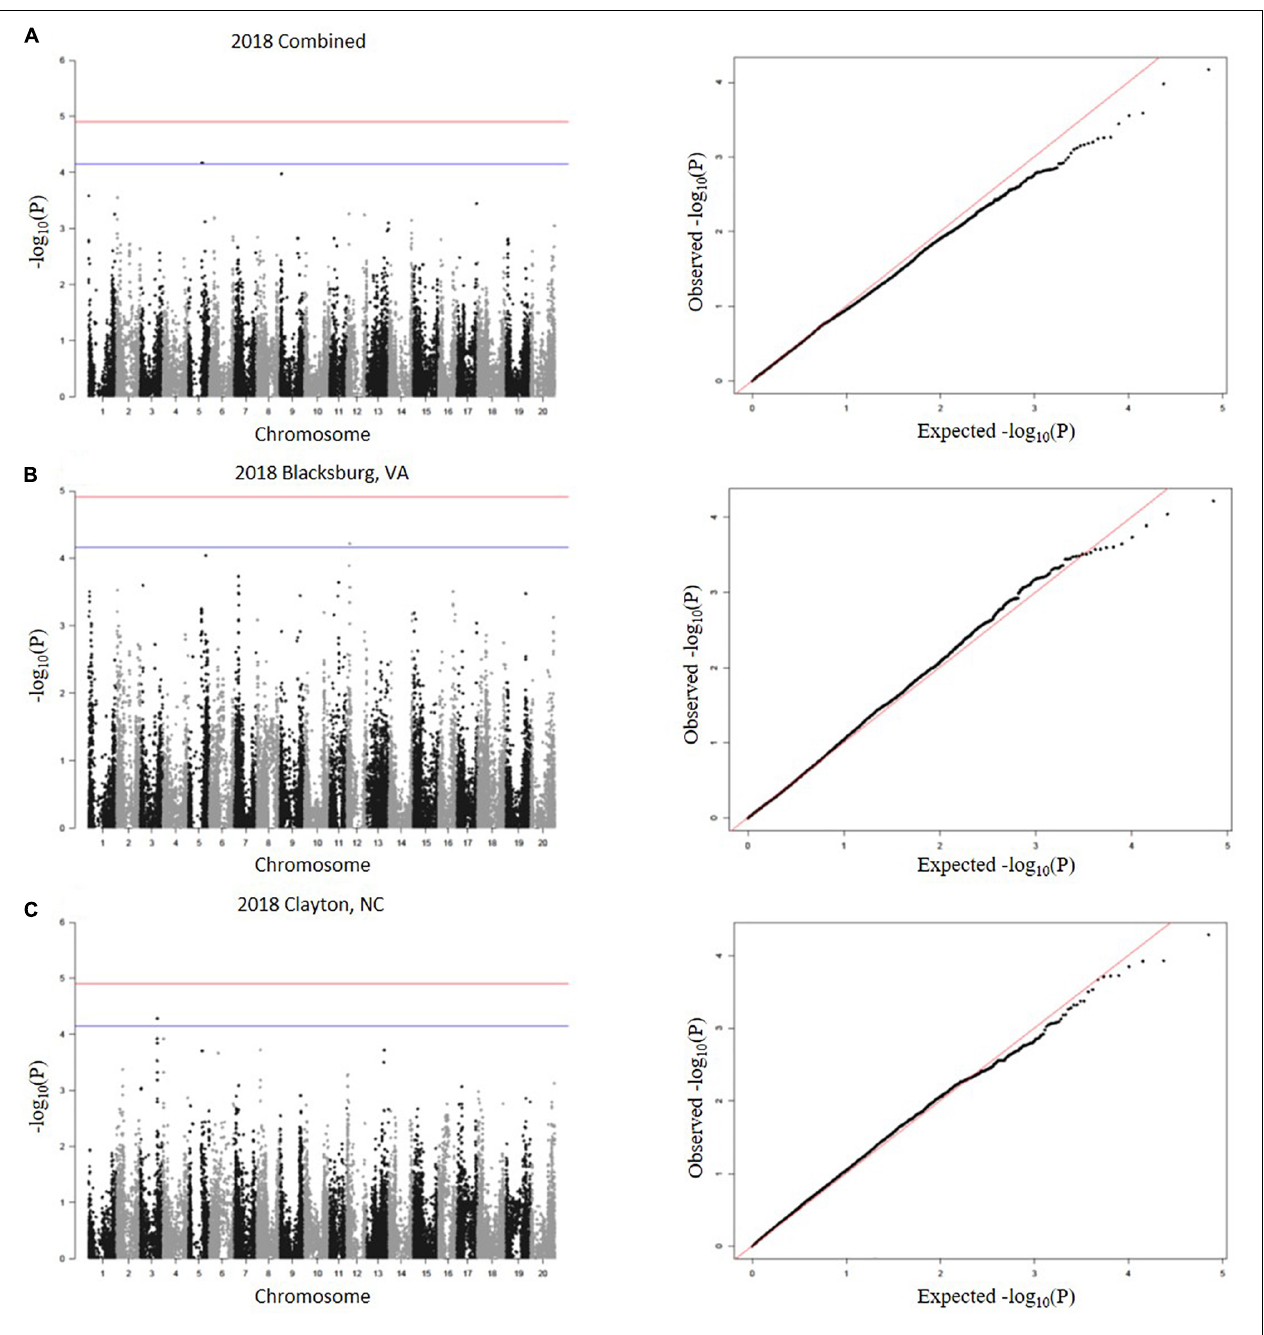
FIGURE 3 | SNP associations for 2018 environments, (A) combined, (B) Blacksburg, VA, (C) Clayton, NC, are displayed in Manhattan plots with chromosomes in alternating colors, significance thresholds-log 10 (P) > 4.91 and suggestive threshold-log 10 (P) > 4.16. Each respective QQ plot displays observed-log 10 (P) against expected-log 10